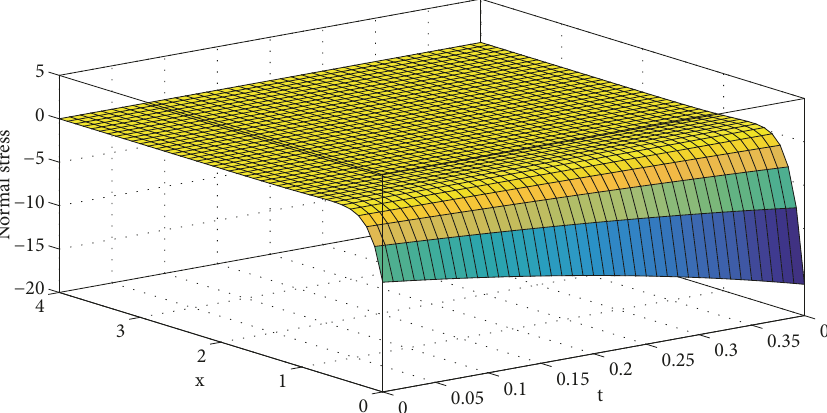
Figure 15: Profile of normal stress distribution at 𝑛 = 1.0 , 𝐻 0 = 10 5 , and Ω = 0.5 .